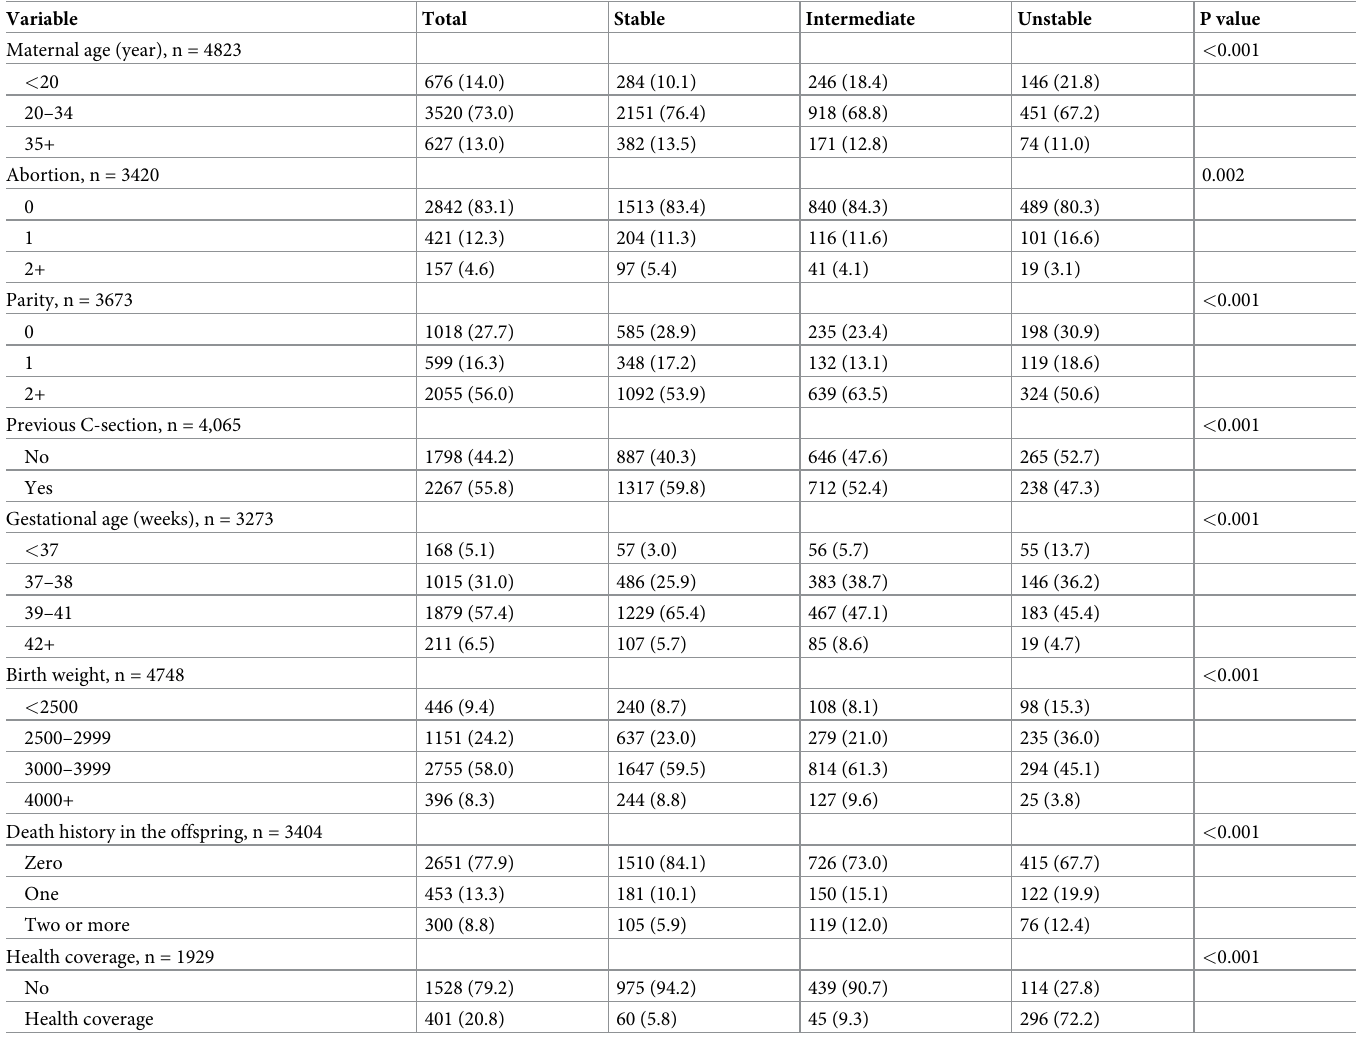
Table 1 displays the socio-demographic and healthcare characteristics of mothers and new- borns. Fourteen percent of the study population were adolescents and this proportion tended to increase with the level of insecurity (p < 0.001). While 16.9% of the study population had a history of at least one abortion, 27.7% were nulliparous and 22.1% had a history of at least one death in the offspring; the proportion of mothers with at least two deaths in the offspring in unstable HZ was over double (12%) than that in stable HZ (5.9%). A history of previous CS was common in 55.8% percent of the study population with an inverse downward trend along the conflict gradient. In unstable HZ, the level of preterm births (13.7%) was 2.4-fold and 4.5-fold higher than that in intermediate and stable health zones respectively (p < 0.001). Like- wise, low birth weight in unstable HZ (15.3%) was 1.9 and 1.8 times more common than in intermediate and stable HZ respectively (p < 0.001). Only 20.8% of women reported having a Table 1. Socio-demographic and healthcare characteristics of mothers and